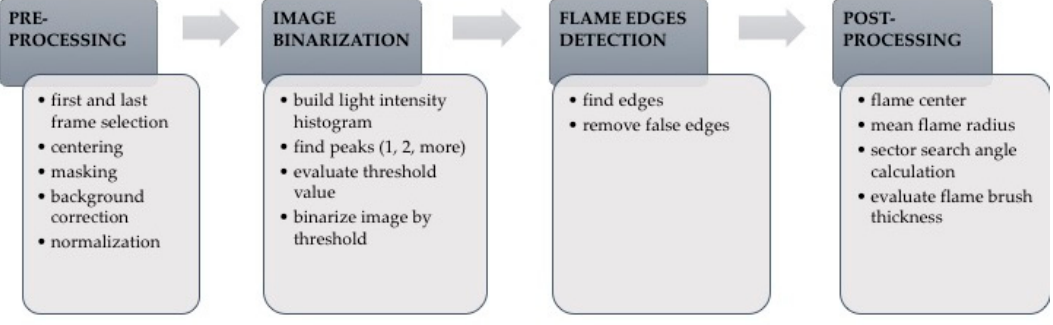
Figure 3. Image processing flowchart.